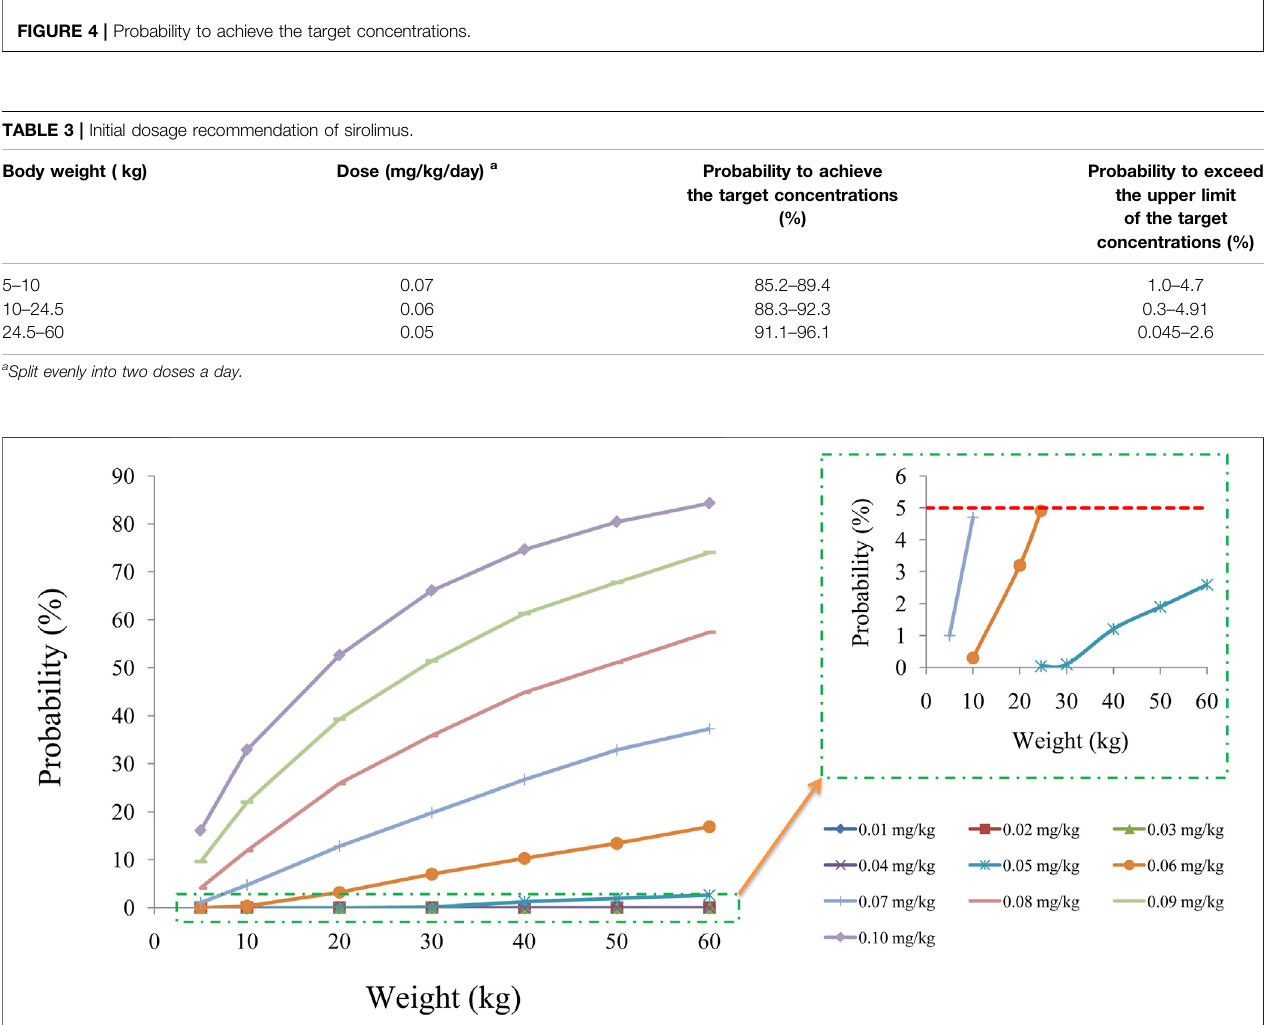
FIGURE 5 | Probability to exceed the upper limit of the target